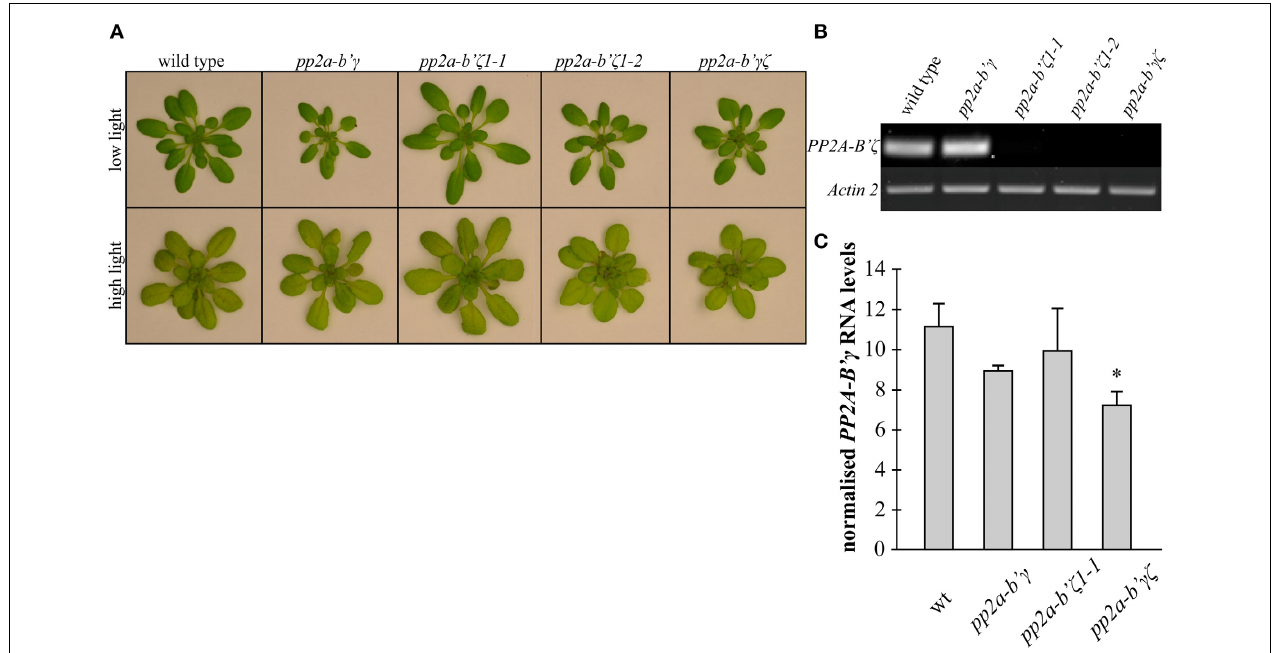
FIGURE 2 | A comparison of the rosette phenotypes of the pp2a-b’ γ , pp2a-b’ ζ 1-1 , pp2a-b’ ζ 1-2 , and the pp2a-b’ γζ double mutant grown under low and high light conditions. (A) Plants grown for 2 weeks under low light (250 μ mol m − 2 s − 1 ) and then either maintained for a further 7 days under low light growth conditions (top row) or transferred to high light (800 μ mol m − 2 s − 1 ) for 7 days (bottom row). A pp2a-b’ γζ double mutant was constructed by crossing the SALK_039172 ( pp2a-b’ γ ) and SALK_107944C ( pp2a-b’ ζ 1-1 ) single mutants. (B) RT-PCR analysis of PP2A-B’ ζ mRNA in wild